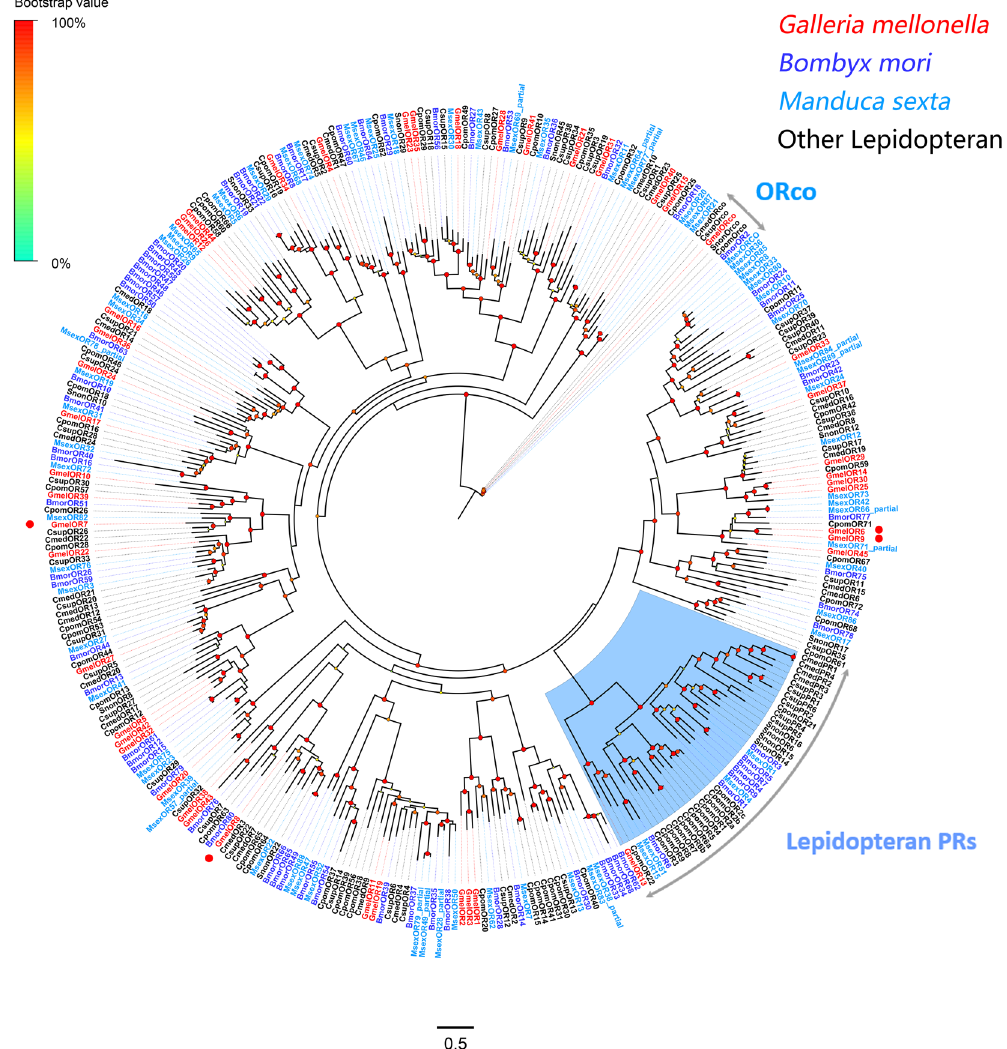
Csup, Chilo suppressalis ; Msex, Manduca sexta ; Snon, Sesamia nonagrioides . Highlighted clades: the lepidopteran pheromone receptor (PR) clade in blue. Node support (circles at the branch nodes) was estimated using an approximate likelihood ratio test based on the scale indicated at the top left. Bars indicate branch lengths in proportion to amino acid substitutions per